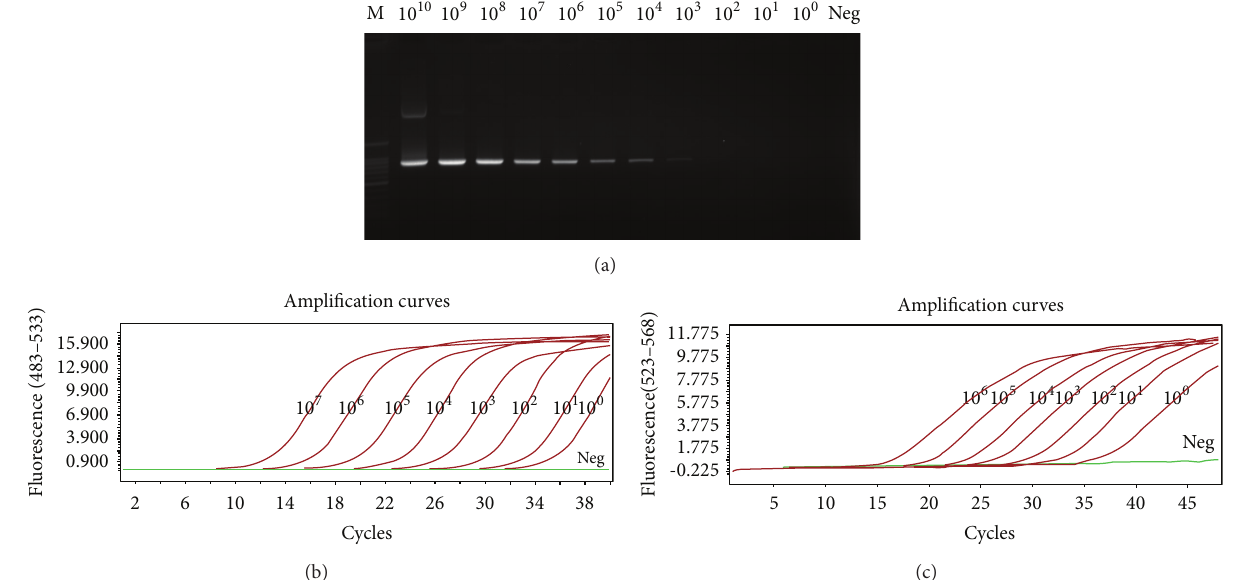
Figure 6: Comparison of sensitivity for PRRSV detection by conventional RT-PCR and real-time PCR. Samples were 10-fold serially diluted plasmid standards of PRRSV. M: 100bp marker; Neg: negative